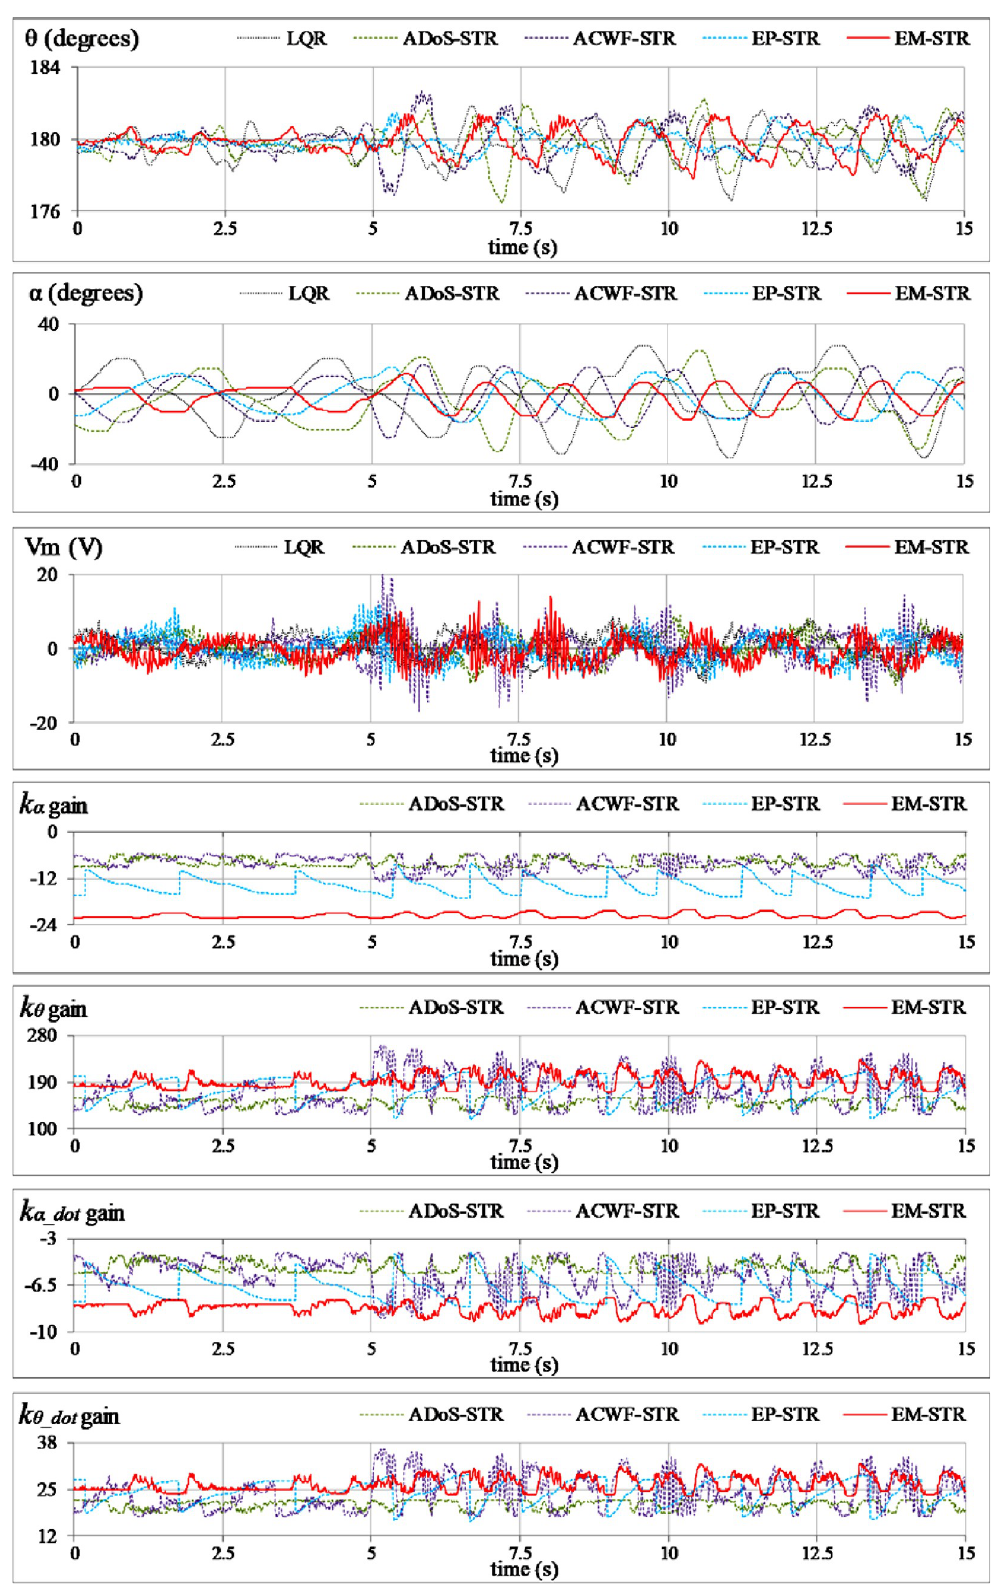
Fig 16. Pendulum’s response under model